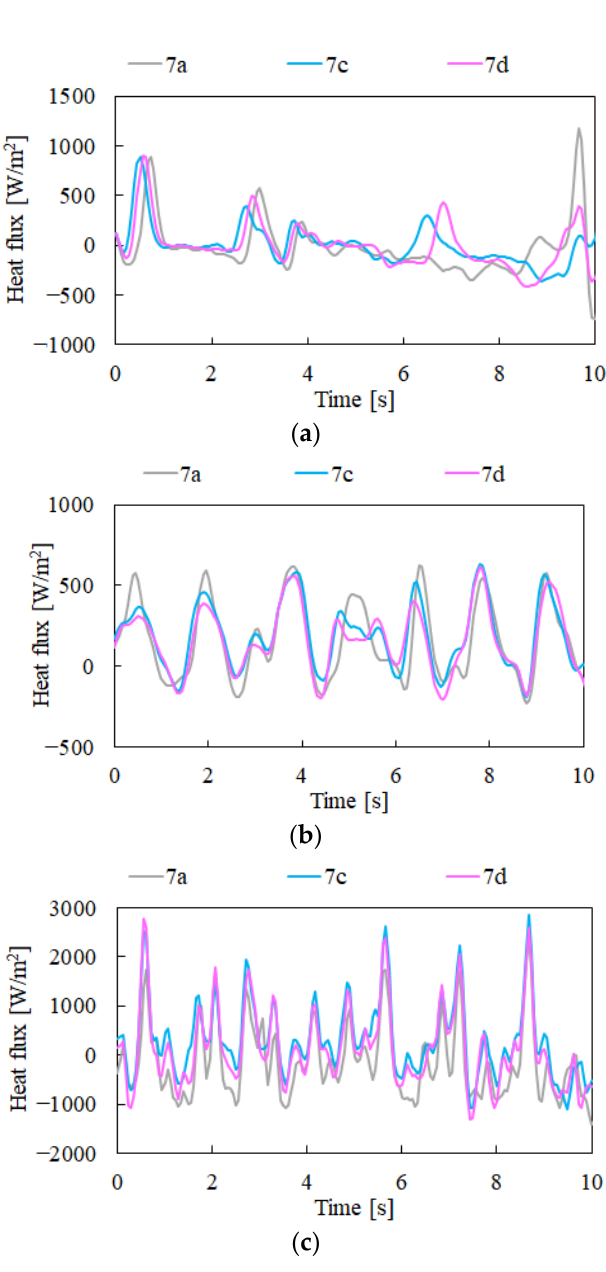
Figure 4. Heat fluxes at 7a, 7c, and 7d: ( a ) Q ele = 0.5 W, ( b ) Q ele = 2 W, ( c ) Q ele = 3.5 W.